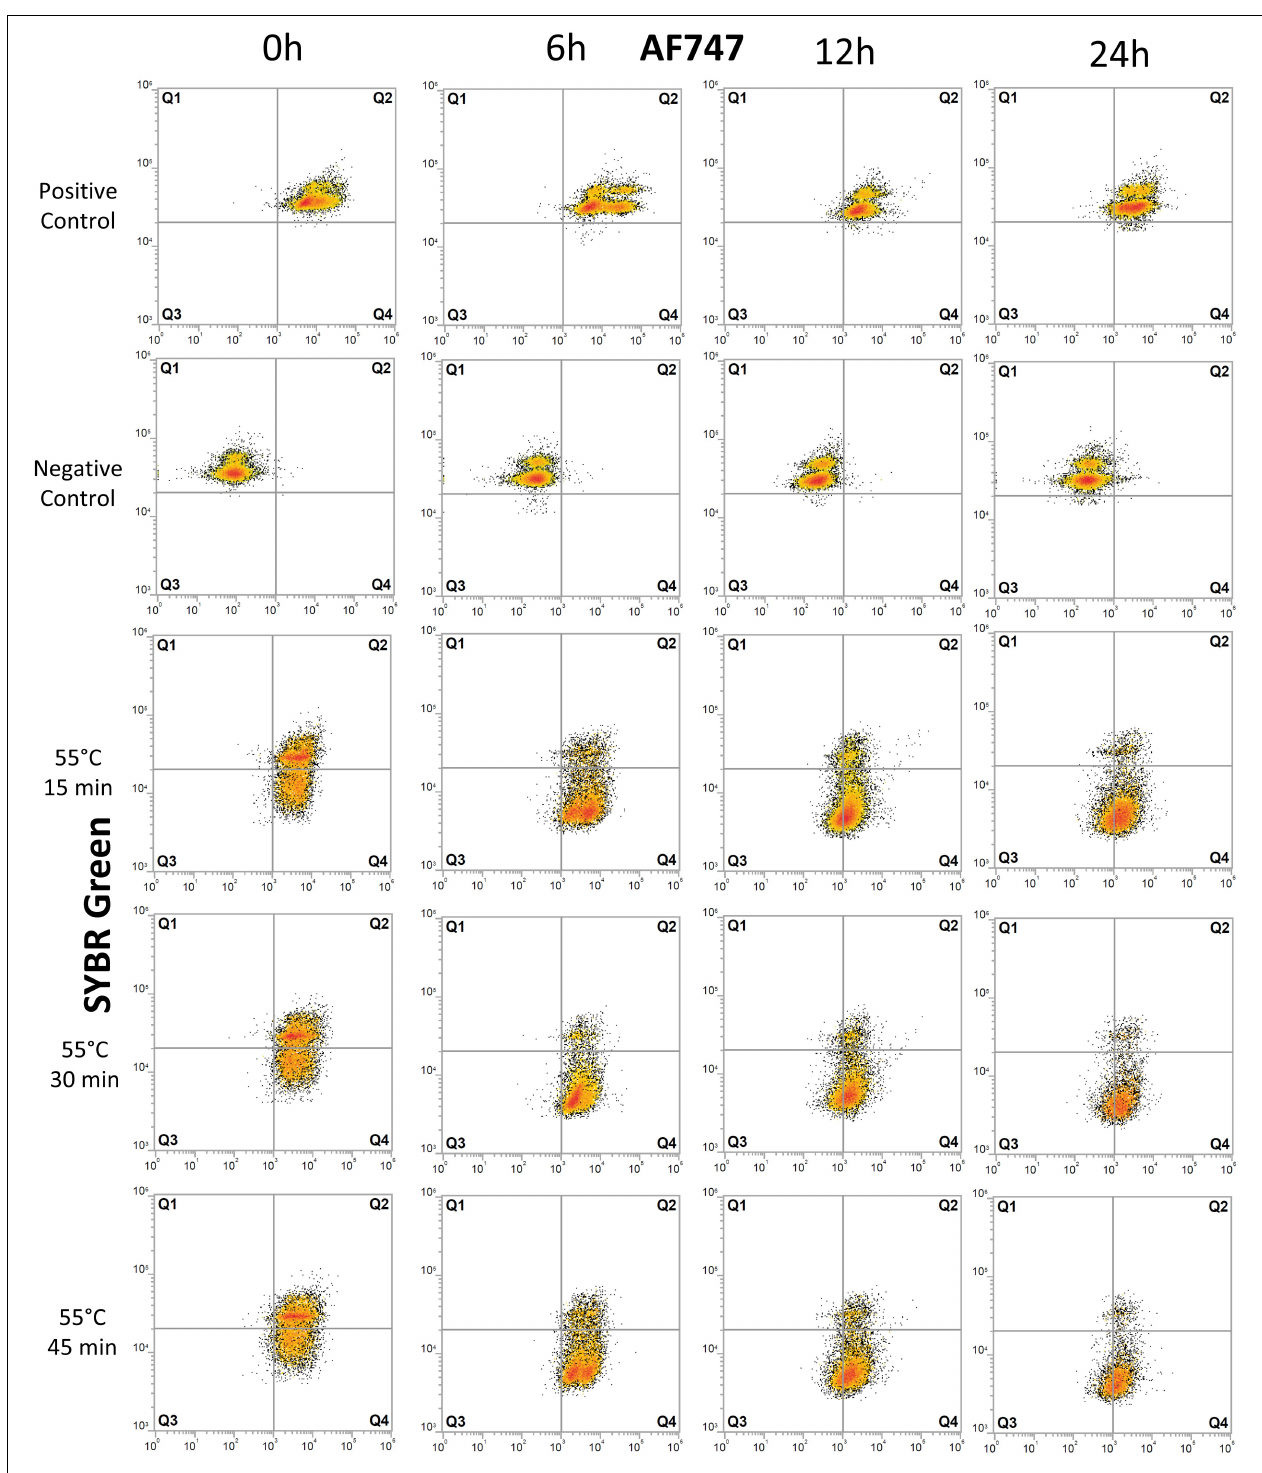
FIGURE 3 | Flow cytometry dot plots of E. coli cells treated with heat. The effects of exposure of E. coli cells to 55 ◦ C for 15, 30, and 45 min were monitored for degradation of DNA and for protein production at 0, 6, 12, and 24 h after treatment. The control samples are the same as those used in the UV experiment ( Figure 2 ). Cells were stained with SYBR Green for DNA detection and AF647 for BONCAT. Between 5,000 and 10,000 cells were analyzed in each dot plot. Gates are identical to those used in Figure 2 .